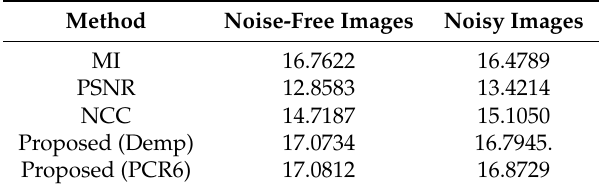
Table 3. Average execution time comparison for dense algorithms (unit